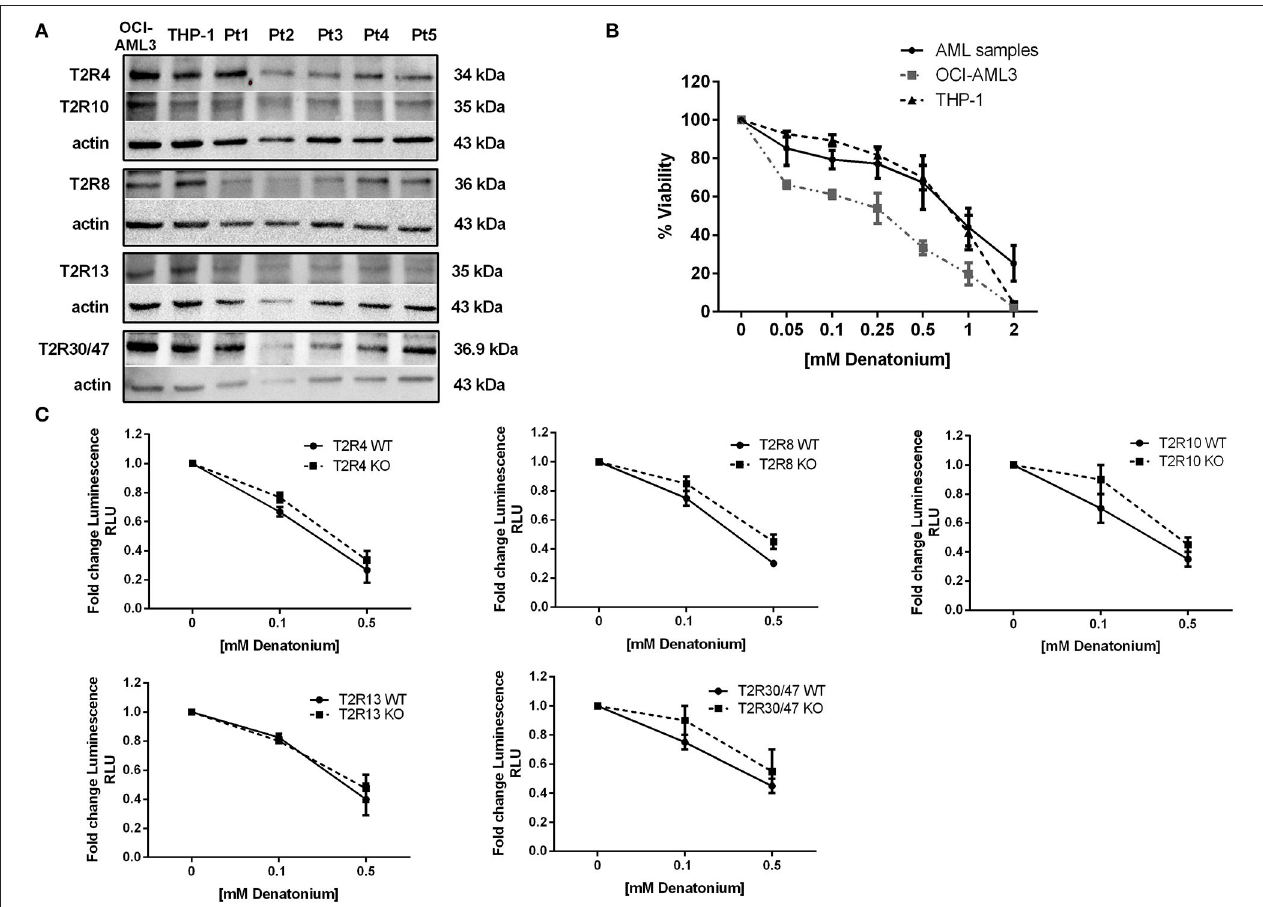
FIGURE 3 | Denatonium affects leukemia cell viability. (A) Western blot analysis of the denatonium-sensitive T2Rs in two AML cell lines and five AML samples (Pt). Actin was shown as the loading control. (B) Cell viability detected by CellTiter 96 Aqueous One Solution assay in AML samples ( n = 7) and AML cell lines ( n = 3 for each cell line) treated for 48h with increasing doses of DEN. (C) Cell viability detected by CellTiter-Glo assay in THP-1 wild type and in T2R4, T2R8, T2R10, T2R13, and T2R30 knockout THP-1 ( n = 3 for each cell